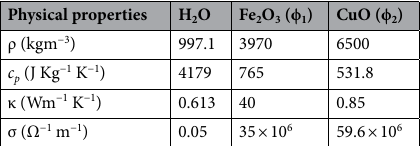
Table 2. Computational values for thermophysical characteristics of base fluid and nanoparticles 2,10